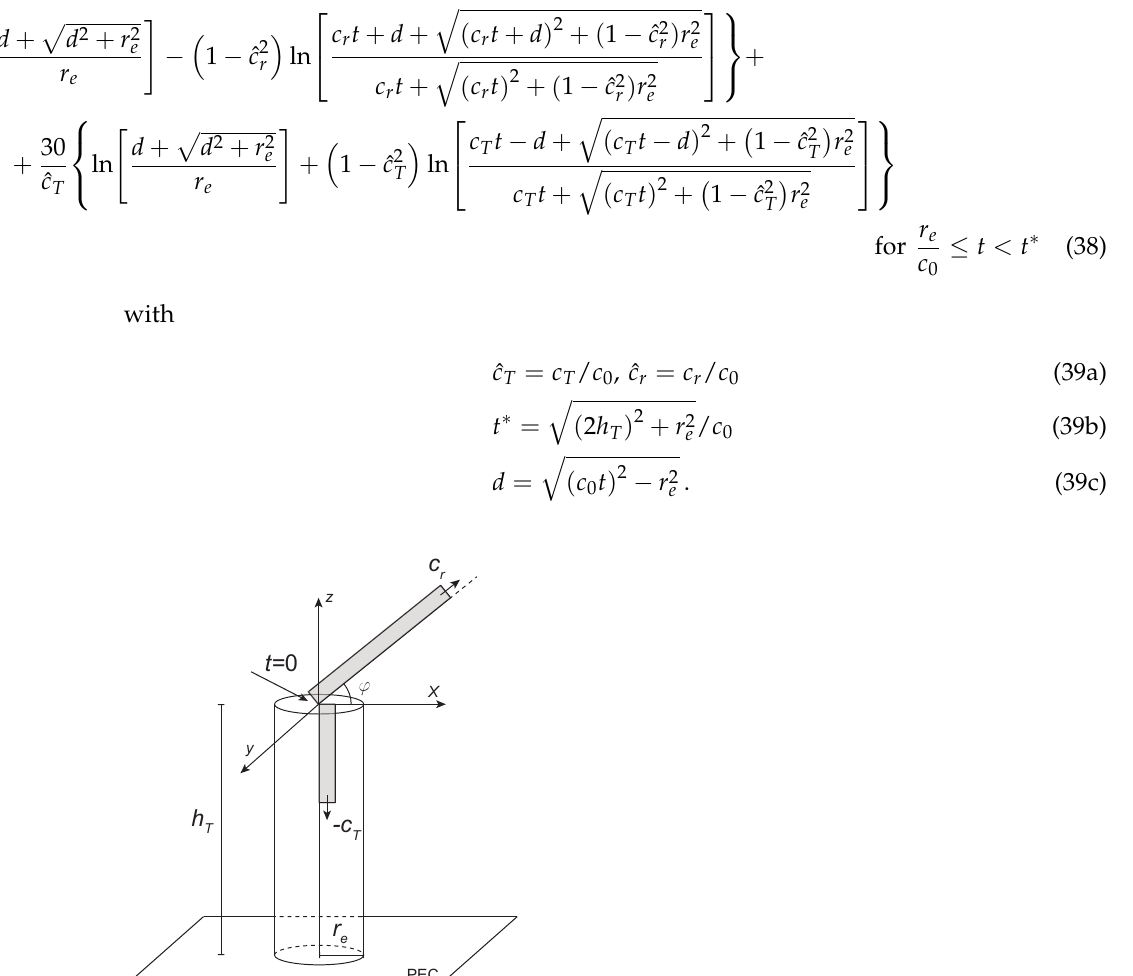
Figure 13. Reference configuration for the derivation of the tower surge impedance adopted by Motoyama et al. [74], considering the influence of the direction of the return-stroke current, and of different velocities of charges in the return-stroke channel and along the tower (represented by an equivalent